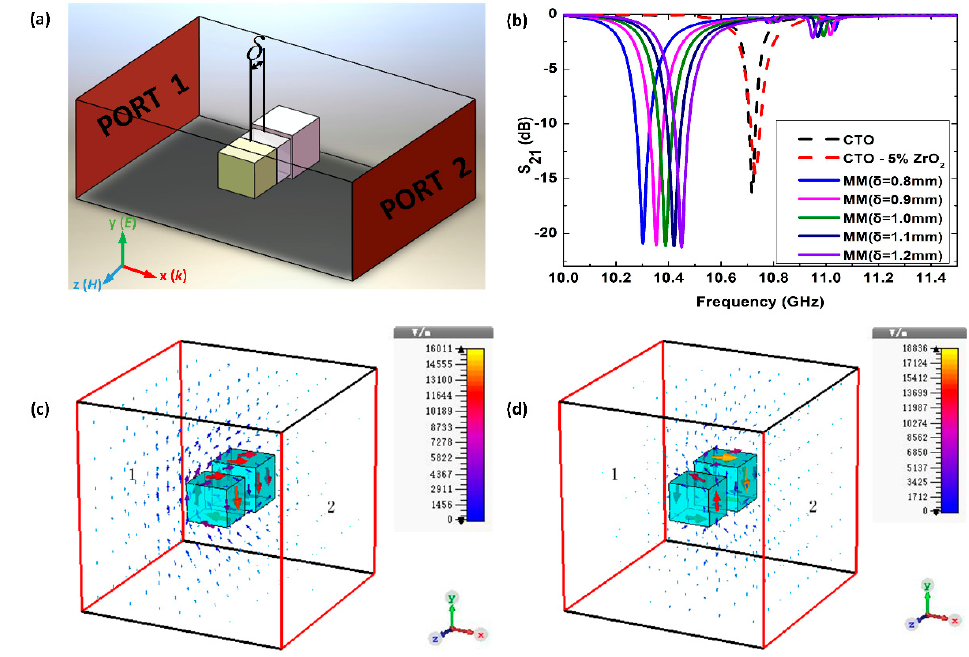
Figure 1. ( a ) Schematic diagram of a metamolecule composed of two dielectric cuboids bonded by a silica gel layer with a thickness δ in a waveguide. ( b ) Simulated transmission curves of CaTiO 3 (CTO) and CaTiO 3 with 5% ZrO 2 (CTO–5%ZrO 2 ), meta-atoms (dash lines) and metamolecule (abbreviated as MM) of different spacings δ (solid lines). At ( c ) 10.45 GHz and ( d ) 10.95 GHz, the displacement electric fields are distributed in two collective modes of metamolecules with δ = 1.2mm.